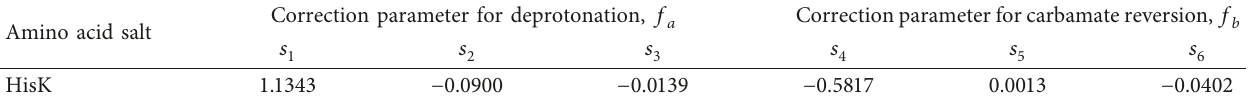
f a and b for equations (28) and (29).